Question: According to this chart, does the measure grow or shrink?
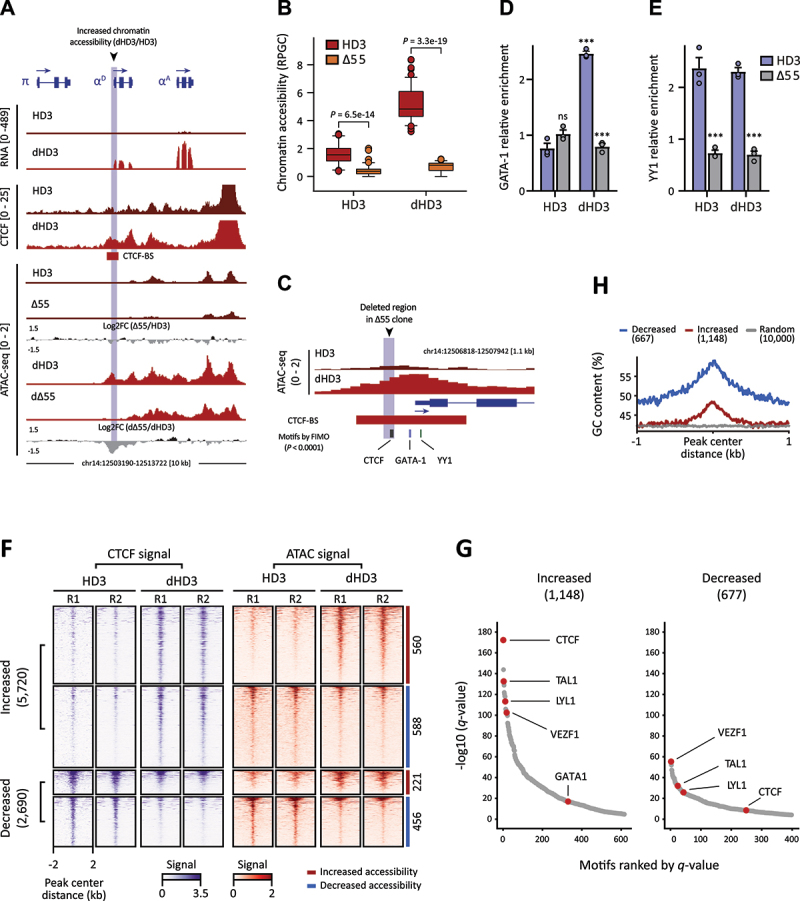
Answer: increasing